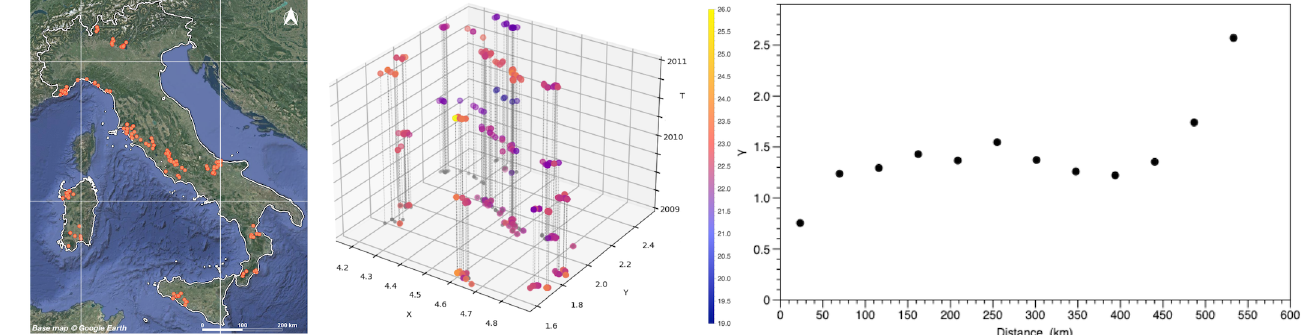
Figure 17. ( Left ): source events spatial distribution. ( Center ): source events spatiotemporal distribu- tion, notice the layered time structure, time is expressed in years, space distances in thousands of kilometers. ( Right ): the spatiotemporal variogram (13), distances in kilometers.